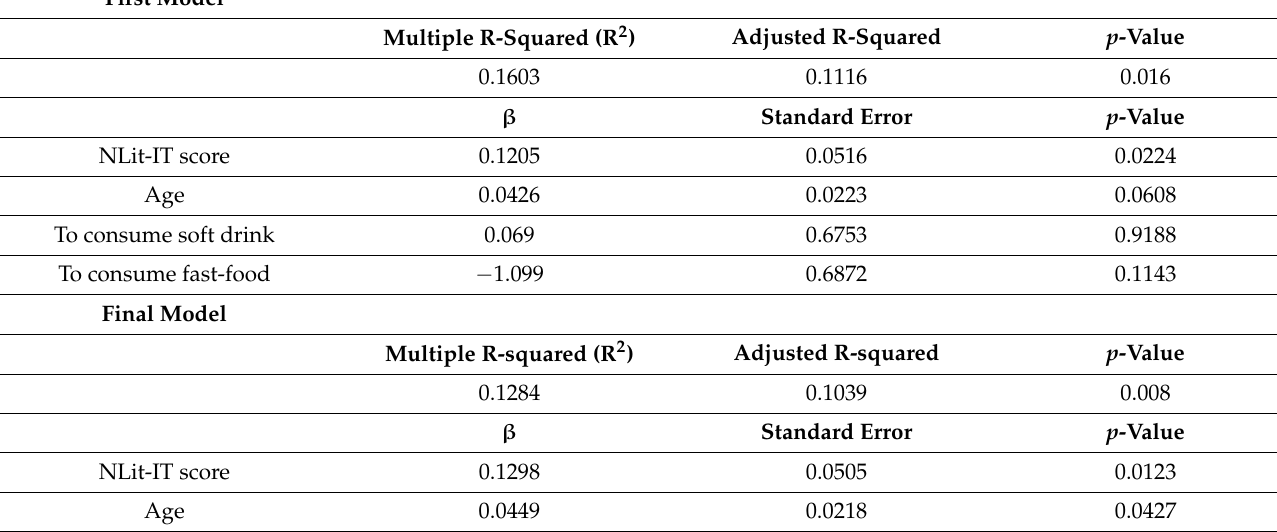
Table 5. In the first model, multivariate model of linear regression analysis was fitted setting up MEDI-Lite score as the dependent variable ( y ) and NLit-IT score, age, “soft drink consumption”, and “fast-food consumption” as independent variables ( x ) because they showed significant associations with MEDI-Lite score performing univariate linear regressions. In the final model, NLit-IT score and age were considered and they confirmed to positive significantly contribute to variability of y